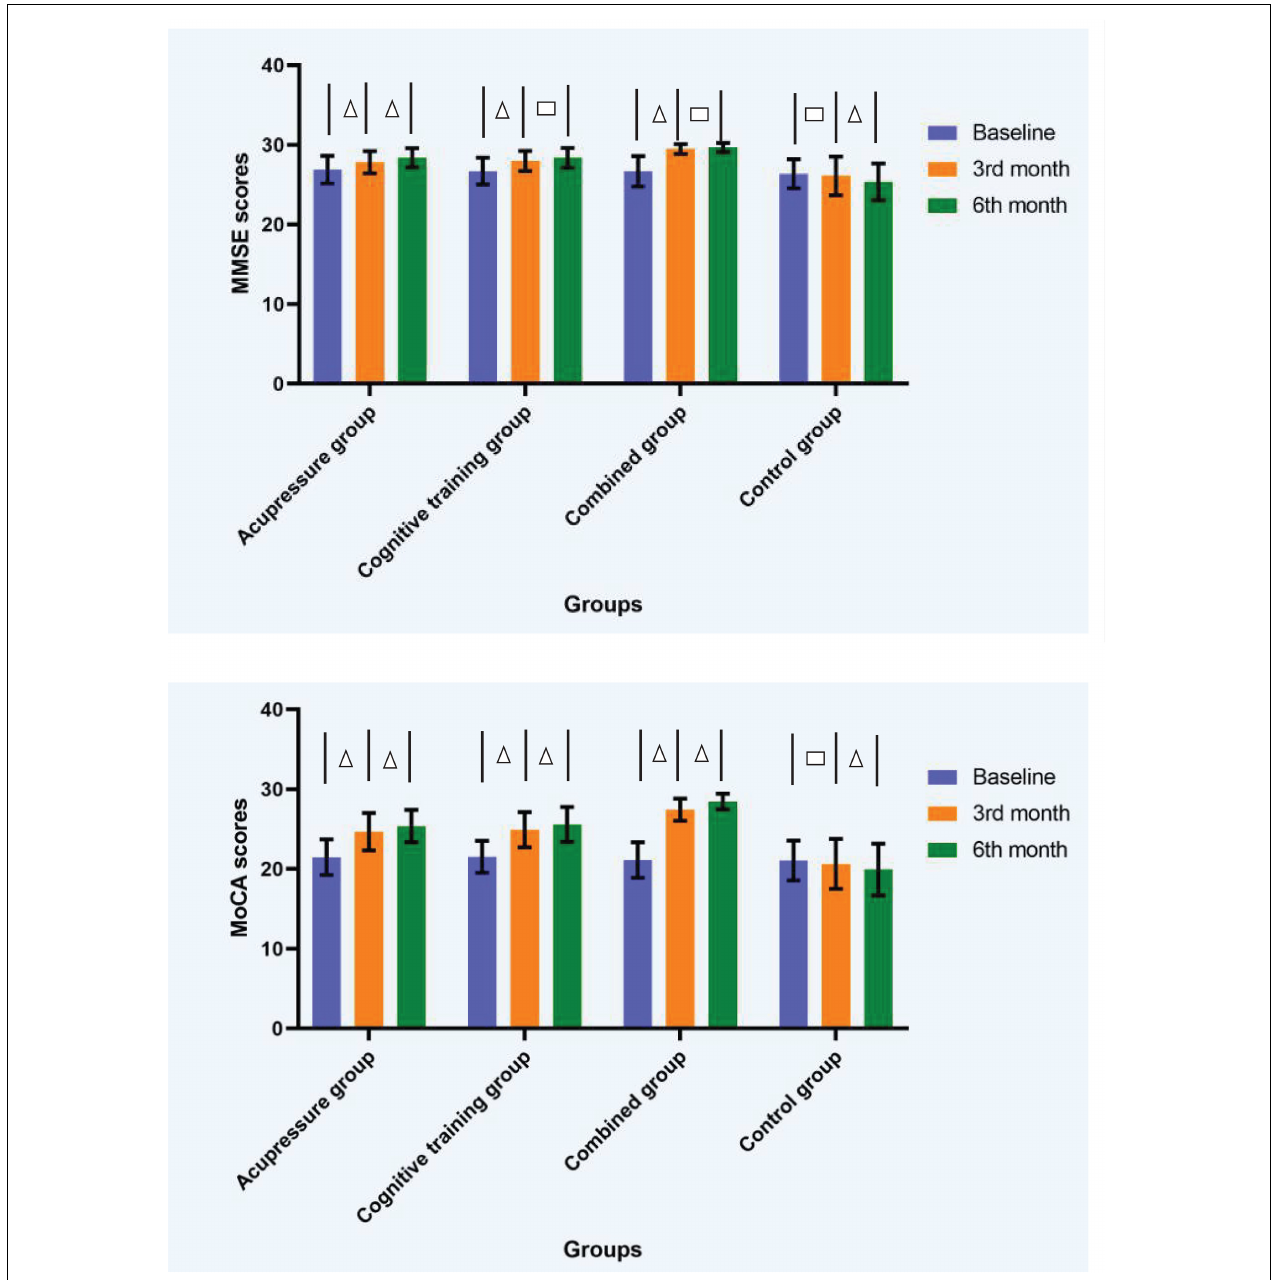
FIGURE 3 | Diagrams showing measure outcomes at different time points among the four groups. (cid:77) The difference of scores of MMSE or MoCA between the two time points was significant ( p < 0.05). (cid:3) The difference of scores of MMSE or MoCA between the two time points was insignificant ( p > 0.05). Error bars based on standard deviation. MMSE, Mini-Mental State Examination; MoCA, Montreal Cognitive